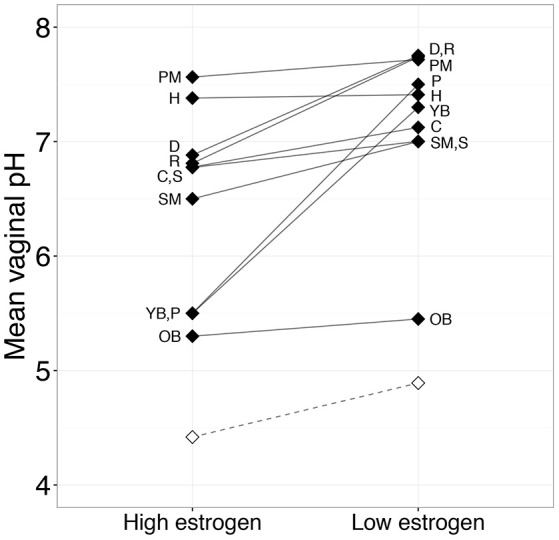
Mean vaginal pH between periods of high and low estrogen of 11 mammalian species during the ovarian cycle. Paired black diamonds represent the overall mean for each species at both estrogen levels. The open diamonds and dashed line show the mean human vaginal pHs during the high estrogen phases (follicular phase and ovulation) and low estrogen phases (luteal phase and menstruation) of the ovarian cycle. Letters next to diamonds identify the mammalian species. See Table S1 for the list of studies used to generate this figure. Abbreviations: C, Cow; D, Dog; H, Horse; OB, Olive baboon; P, Common brushtail possum; PM, Pig-tailed macaque; R, Brown rat; S, Sheep; SM, Black-handed spider monkey; YB, Yellow baboon.